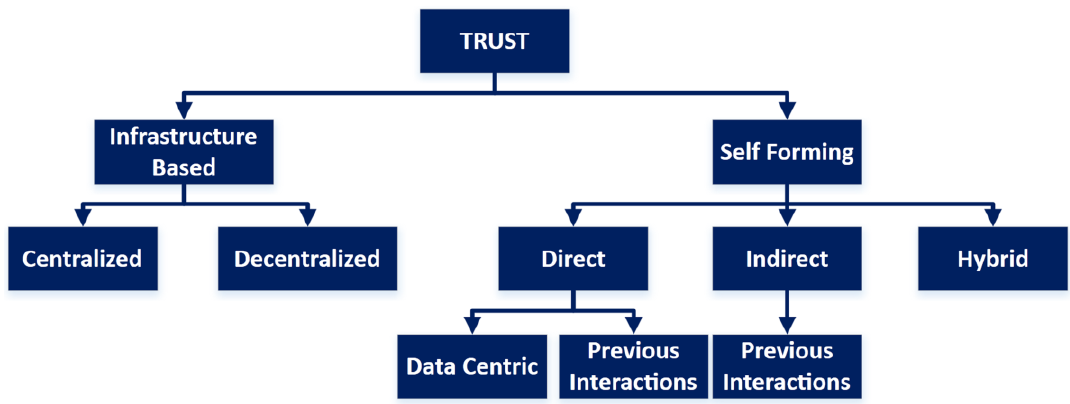
Figure 5. Classification of trust establishment